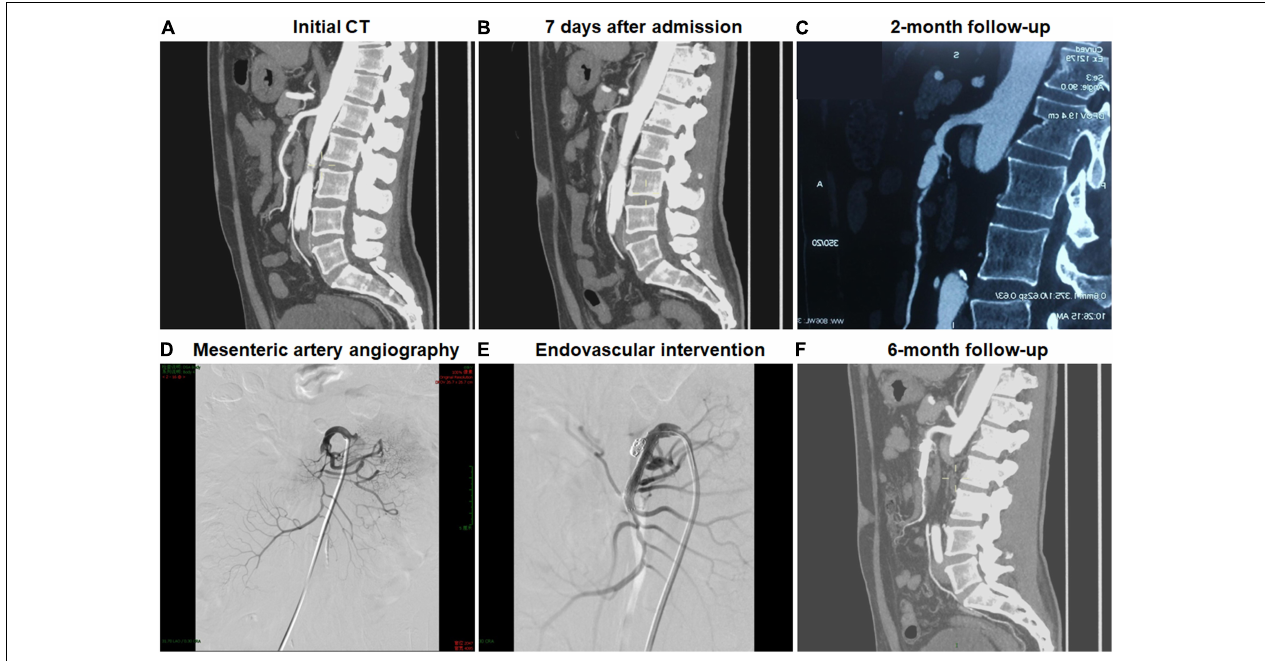
FIGURE 1 | Endovascular coiling assisted stent placement and follow-up computed tomography (CT) for type III developed into type II spontaneous isolated superior mesenteric artery dissection. (A,B) Initial and 1-week CT angiography showed the thrombosed false lumen with ulcer-like projection in a 52-year-old man. (C) Two months later, type III lesion evolved into type II dissection with a patent “cul-de-sac” false lumen but no re-entry, and the true lumen was severely compressed. (D) Mesenteric artery angiography revealed the dissection formation and the occlusion of the main trunk. (E) Type II dissection was treated using stent placement and coil embolization via stent mesh. (F) Six month later, the stent remained patent. TABLE 2 | Follow-up computed tomography results of conservative treatment according to the angiographic findings. All patients Type